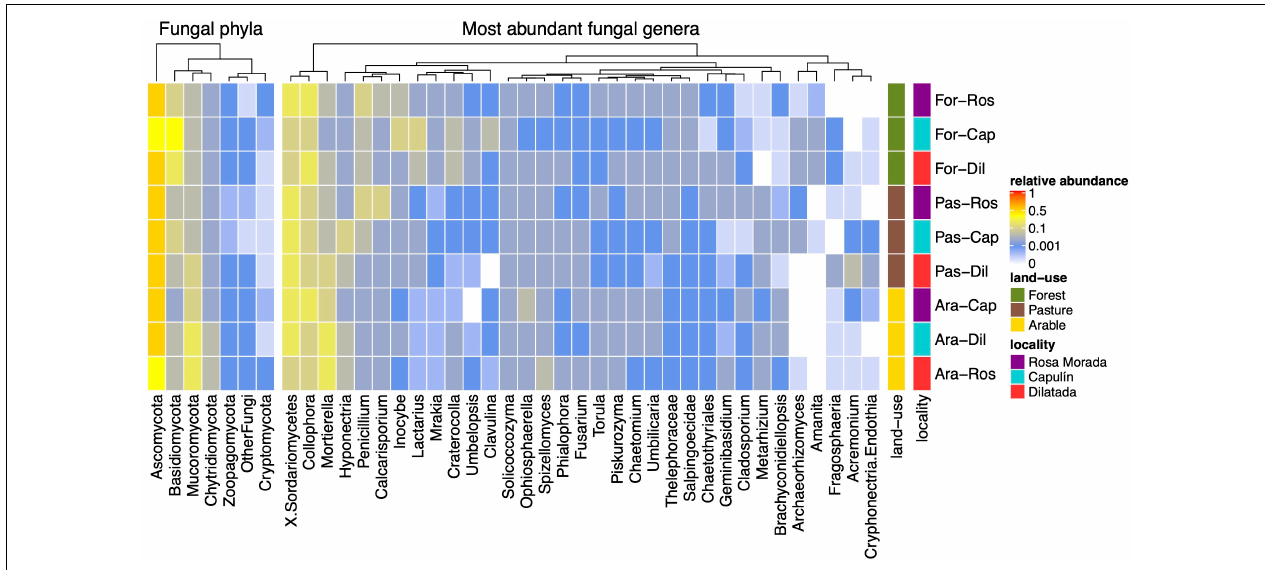
FIGURE 2 | Heat-map of the relative abundance of the fungal phyla and the most abundant fungal genera in a coniferous forest soil (Forest), deforested for grazing (Pasture), and in maize ( Z. mays L.) cultivated deforested soil (Maize) at the “ Área de Protección de Flora y Fauna Nevado de Toluca ”